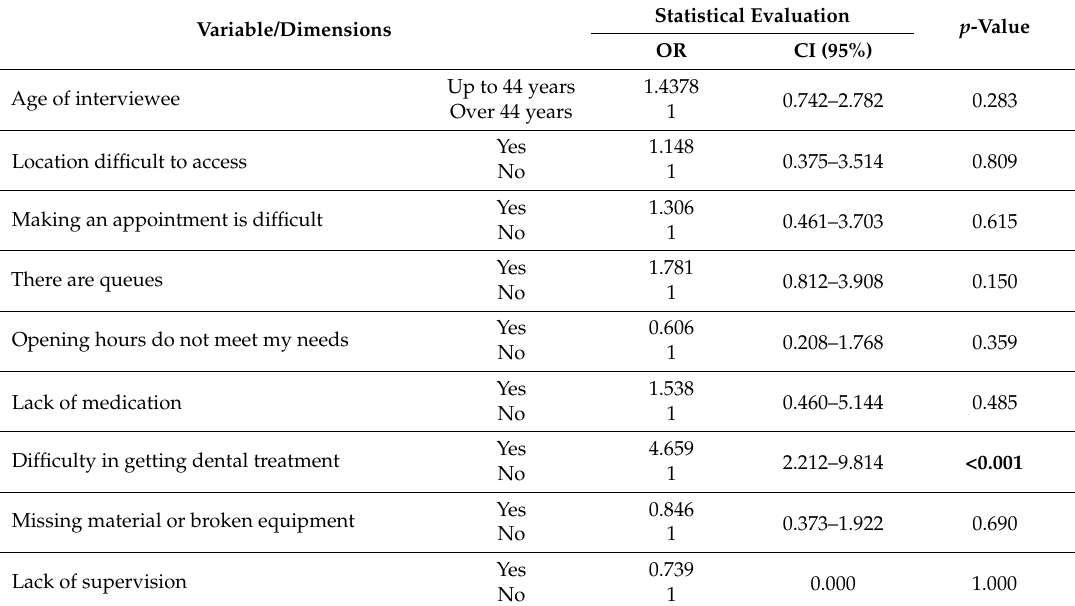
Table 3. Binary logistic regression analysis of users’ unfavorable perceptions regarding the Specialized Dental Clinics (SDC)’s oral health services and sociodemographic and service-related variables ( n =